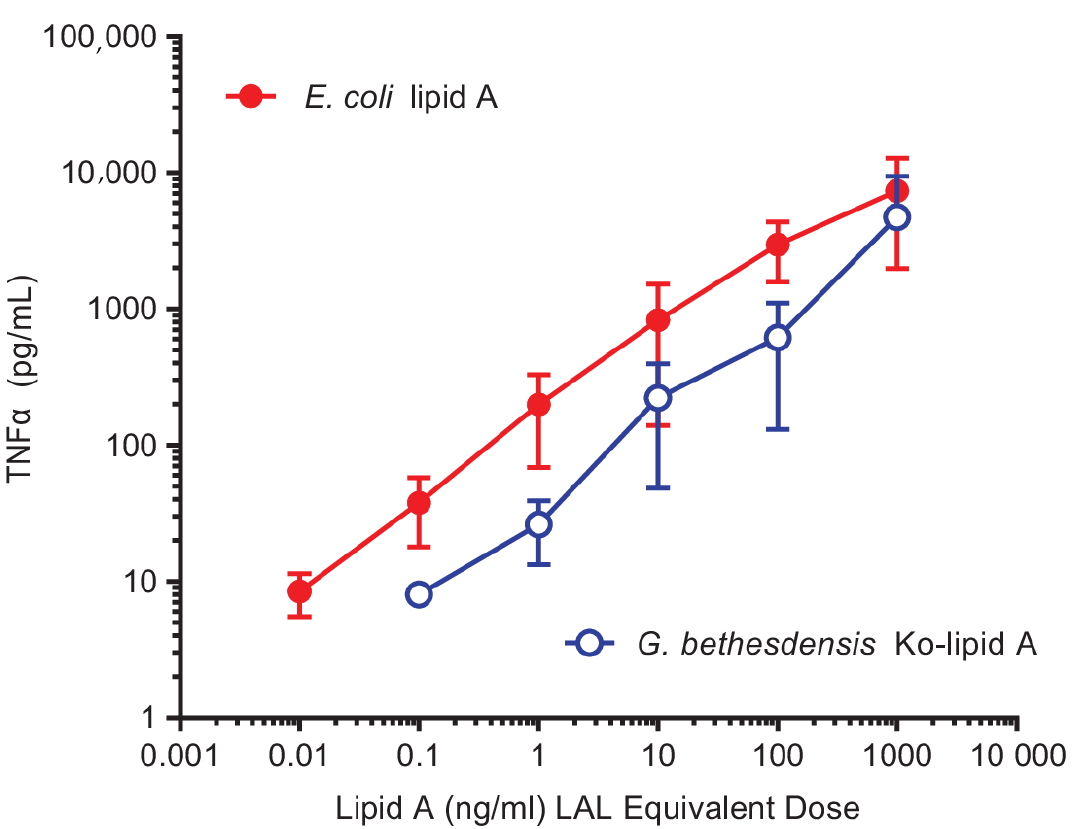
Figure 7. Induction of TNF α secretion in human blood ex vivo: Limulus amoebocyte lysate (LAL) equivalent doses of G. bethesdensis Ko–lipid A or E. coli lipid A were added to blood and incubated for 6 h, and the resulting supernatants were assayed for TNF α concentration by ELISA. Data shown represent the mean ± SD ( n = 12